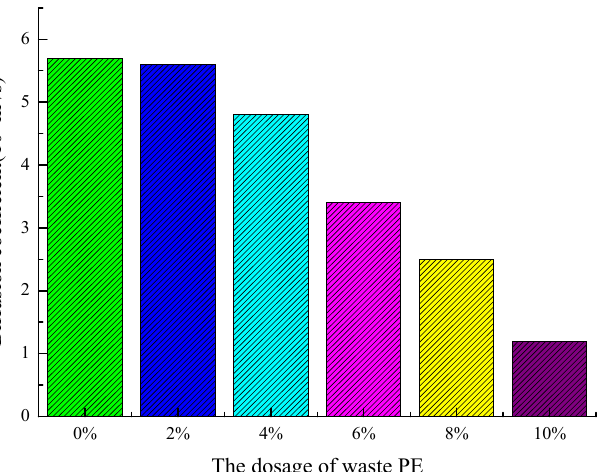
Figure 3. Diffusion coefficient of waste polyethylene in waste plastic/rubber-modified asphalt.